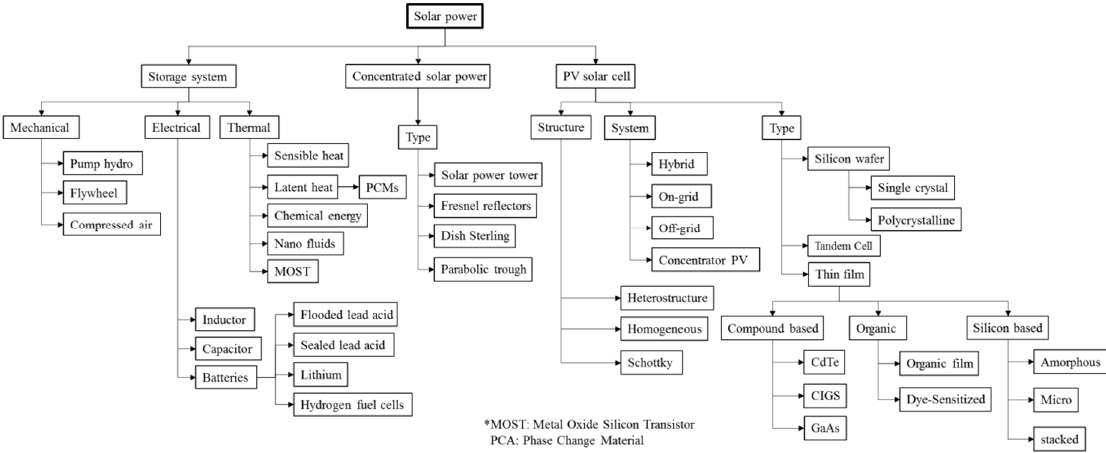
Figure 5. A structured knowledge ontology describes key solar power technologies.